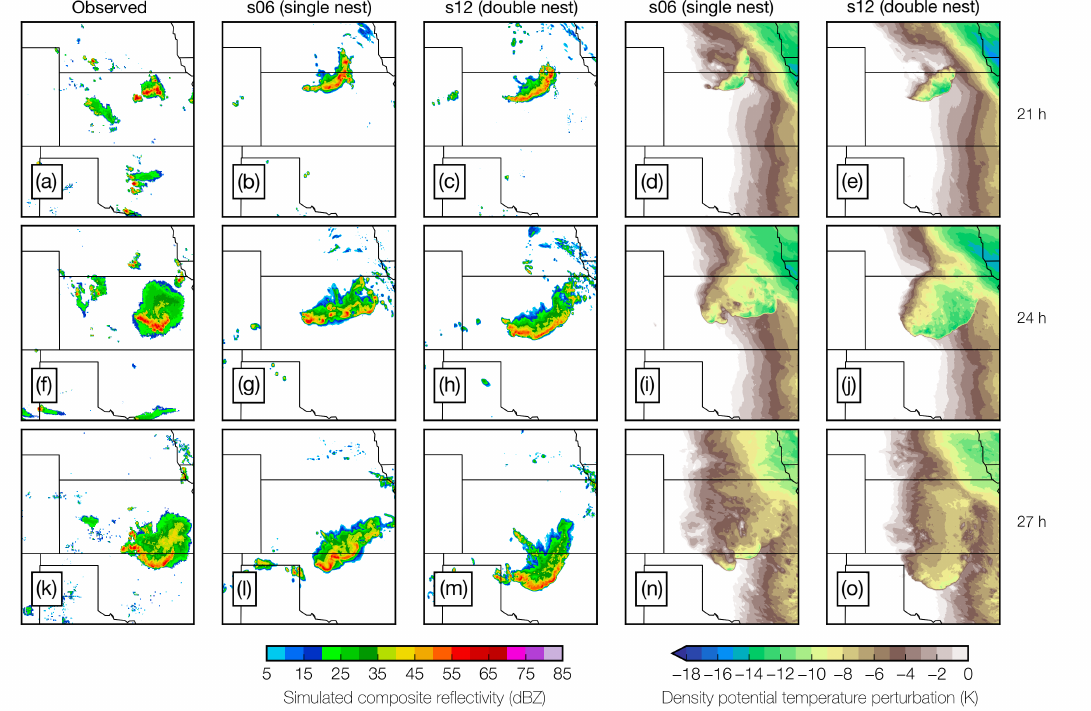
Figure 7. Observed composite reflectivity (leftmost column), and simulated fields of composite reflectivity (second and third column from left) and density potential temperature perturbation (two rightmost columns) from total absolute SAL median single- and double-nest EPS members. Fields are valid at 2100UTC on Day 1 ( a – e ), 0000UTC on Day 2 ( f – j ), and 0300UTC on Day 2 ( k – o ). Times are listed on the right as hours since